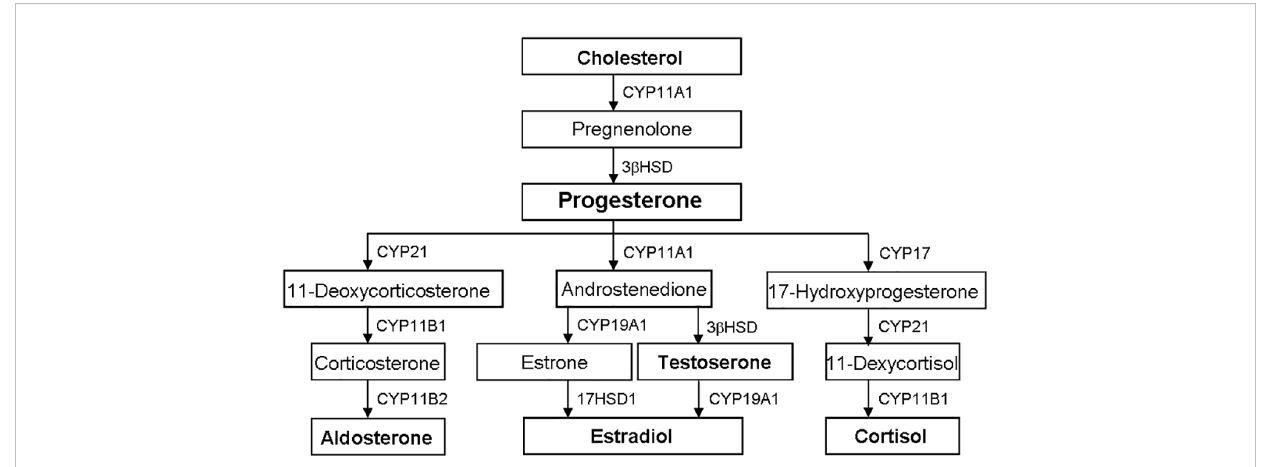
FIGURE 2 Biosynthetic pathways of steroid hormones. The biosynthesis of steroid hormones is from cholesterol through the sequence activity of CYP and HSD. Progesterone is the precursor of other steroid hormones, such as aldosterone, testosterone, estradiol and cortisol. CYP, cytochrome P450; HSD, hydroxysteroid